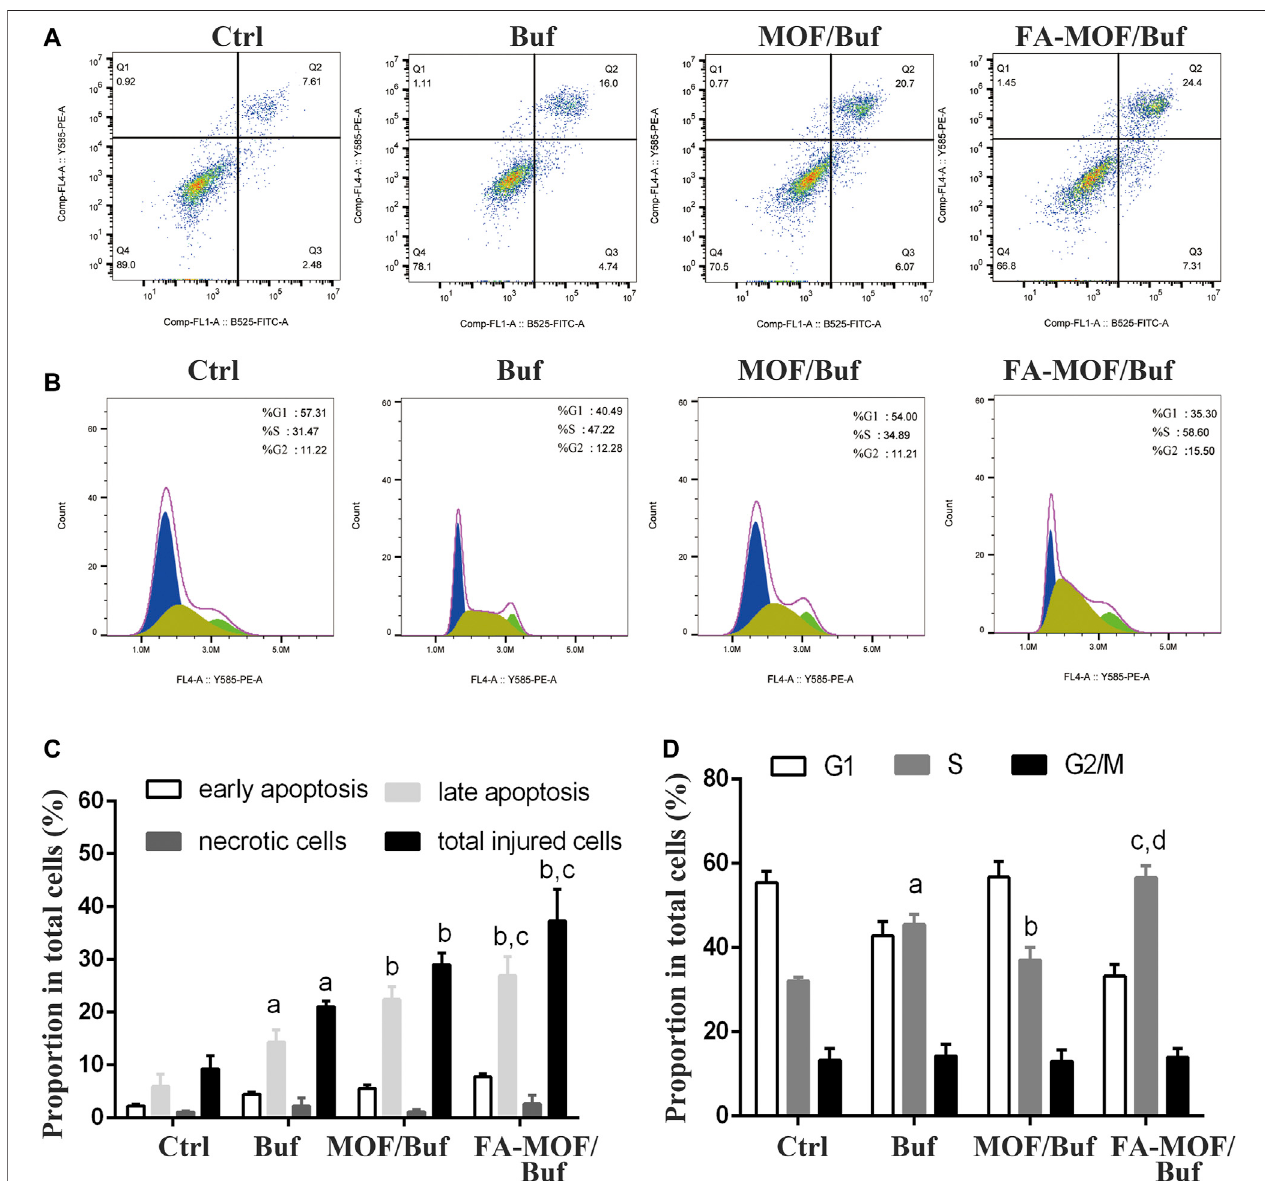
FIGURE 2 | Cell apoptosis and cycle of MCF-7 cells after treatment with NPs. (A) Apoptosis analysis; (B) Cell cycle analysis; (C) Quantitative analysis of cell apoptosis, a p < 0.05 vs. ctrl, b p < 0.01 vs. Buf, c p < 0.05 vs. MOF/Buf ( n (cid:1) 3); (D) Quantitative analysis of cell cycle, a p < 0.01 vs. ctrl, b p < 0.05 vs. Buf, c p < 0.01 vs. Buf, d p <